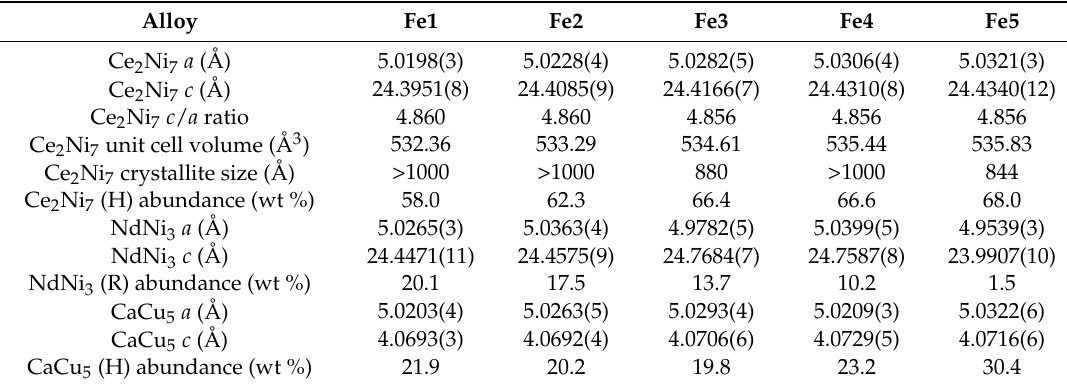
Table 2. Lattice constants a and c , c / a ratio, unit cell volume, and crystallite size of the main Ce 2 Ni 7 phase from a full-pattern fitting, and phase abundances calculated from XRD analysis of alloys Fe1–Fe5. Error ranges are indicated in parentheses after the lattice parameters. R: rhombohedral; and H: hexagonal.